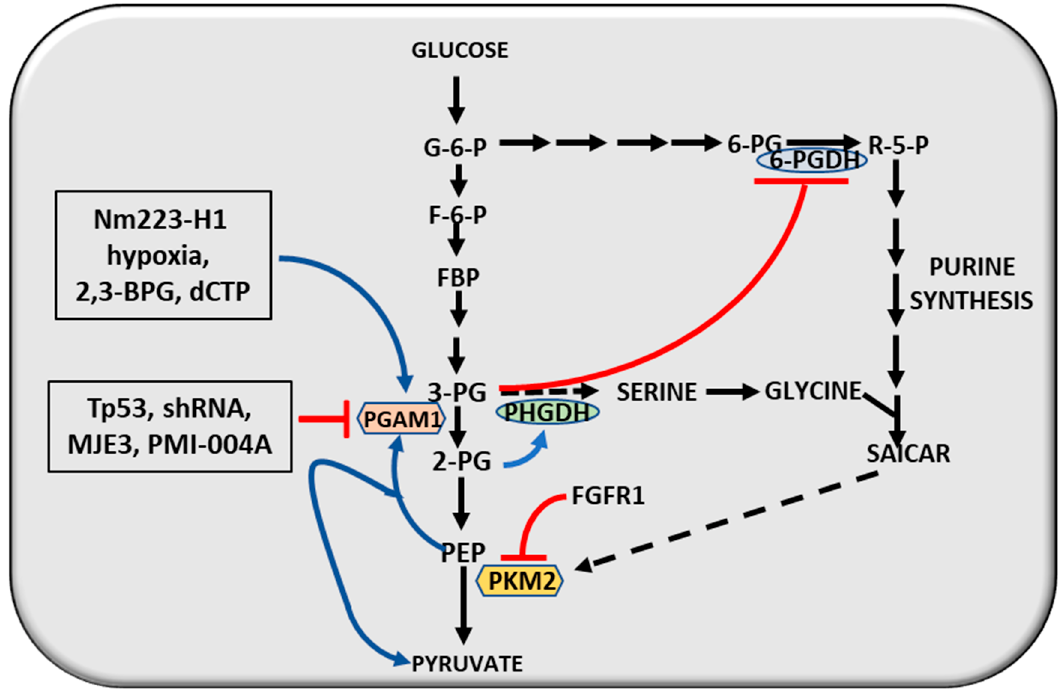
Figure 6. Reciprocal regulation of glycolysis and pentose phosphate pathway. Explanations in the text.